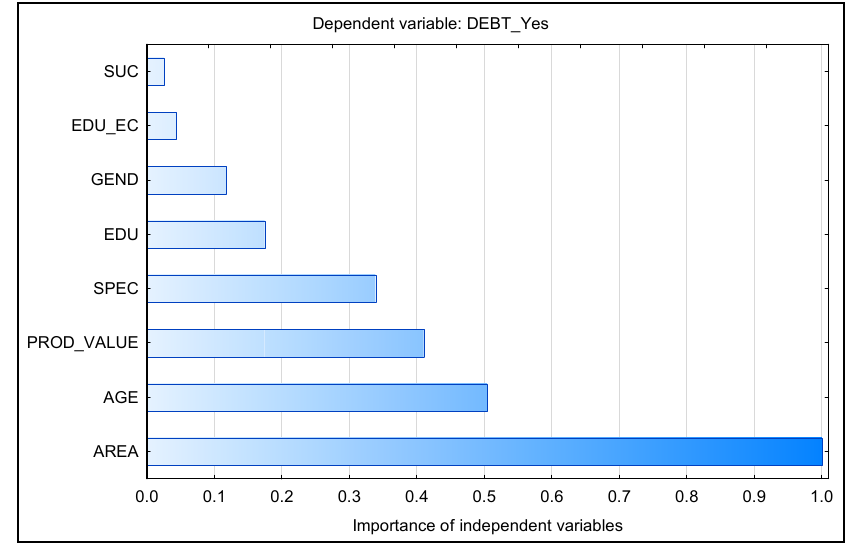
Figure 3. Importance of independent variables . Note: Scale 0–1; 0—variable is no important; 1— variable is very important. Source: Own